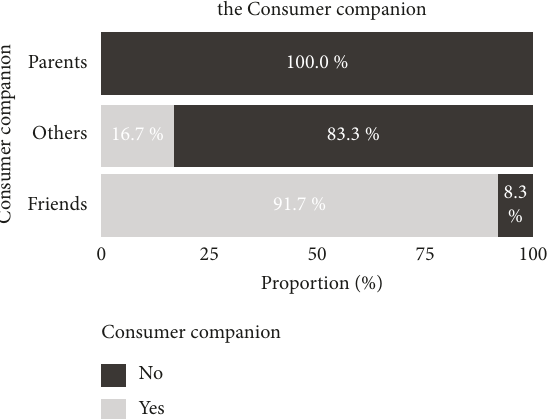
Figure 8: Distribution of the subjects according to the companions with whom they frequently consume cannabis.